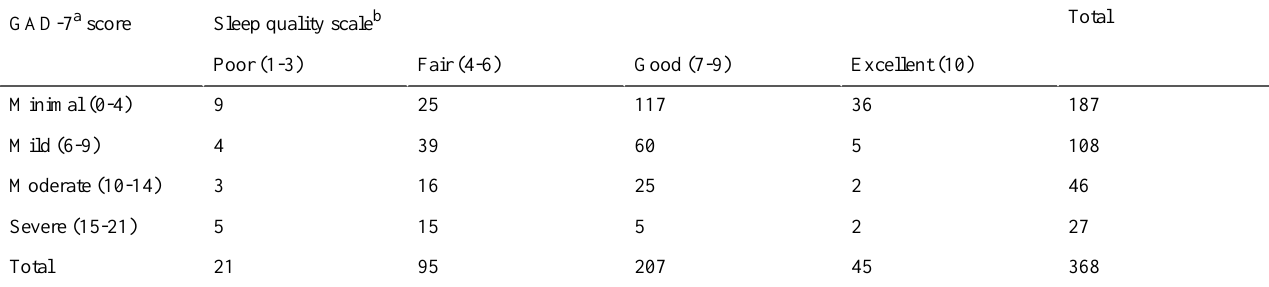
Table 5. Correlation of Generalized Anxiety Disorder, 7-item (GAD-7) scores and quality of sleep scores among health care